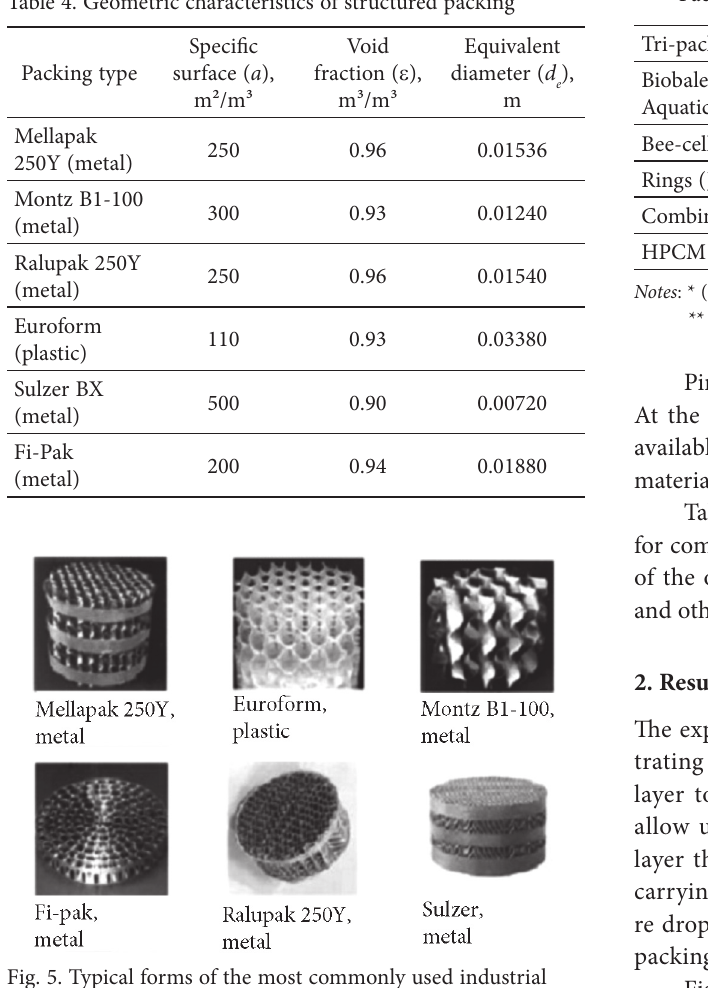
Table 4. Geometric characteristics of structured packing